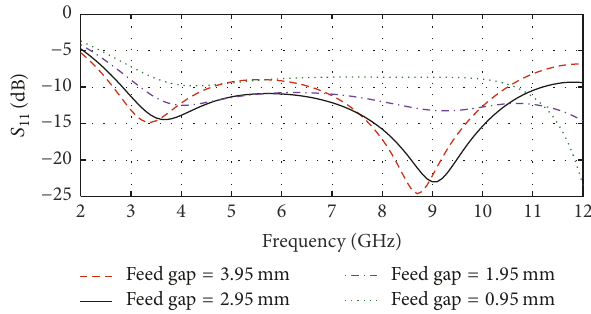
Figure 5: Effect of feed gap variation on impedance bandwidth.